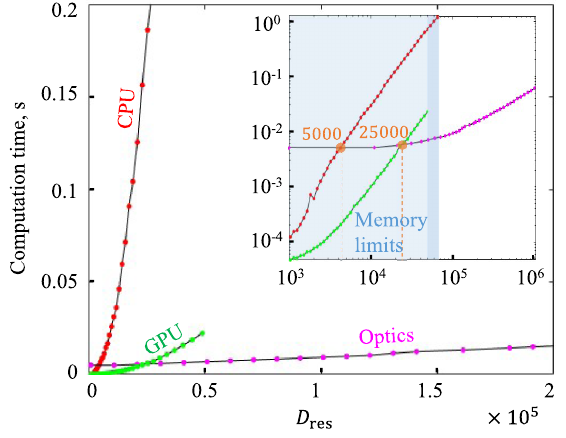
FIG. 6. Computation time of one reservoir state for different reservoir sizes performed on high-end CPU, GPU, and the proposed optical scheme. The inset shows the performance curves in a logarithmic scale extended for larger reservoir sizes. The turning points where the optical scheme starts to perform faster than the CPU and GPU correspond to D ≈ 25000 , respectively. Note that the largest reservoir size D res used in this work for the prediction task is 50 000 (see Fig. 5), which is close to the CPU and GPU memory limits and where our implementation is about 4 times faster than the GPU and 100 times faster than the